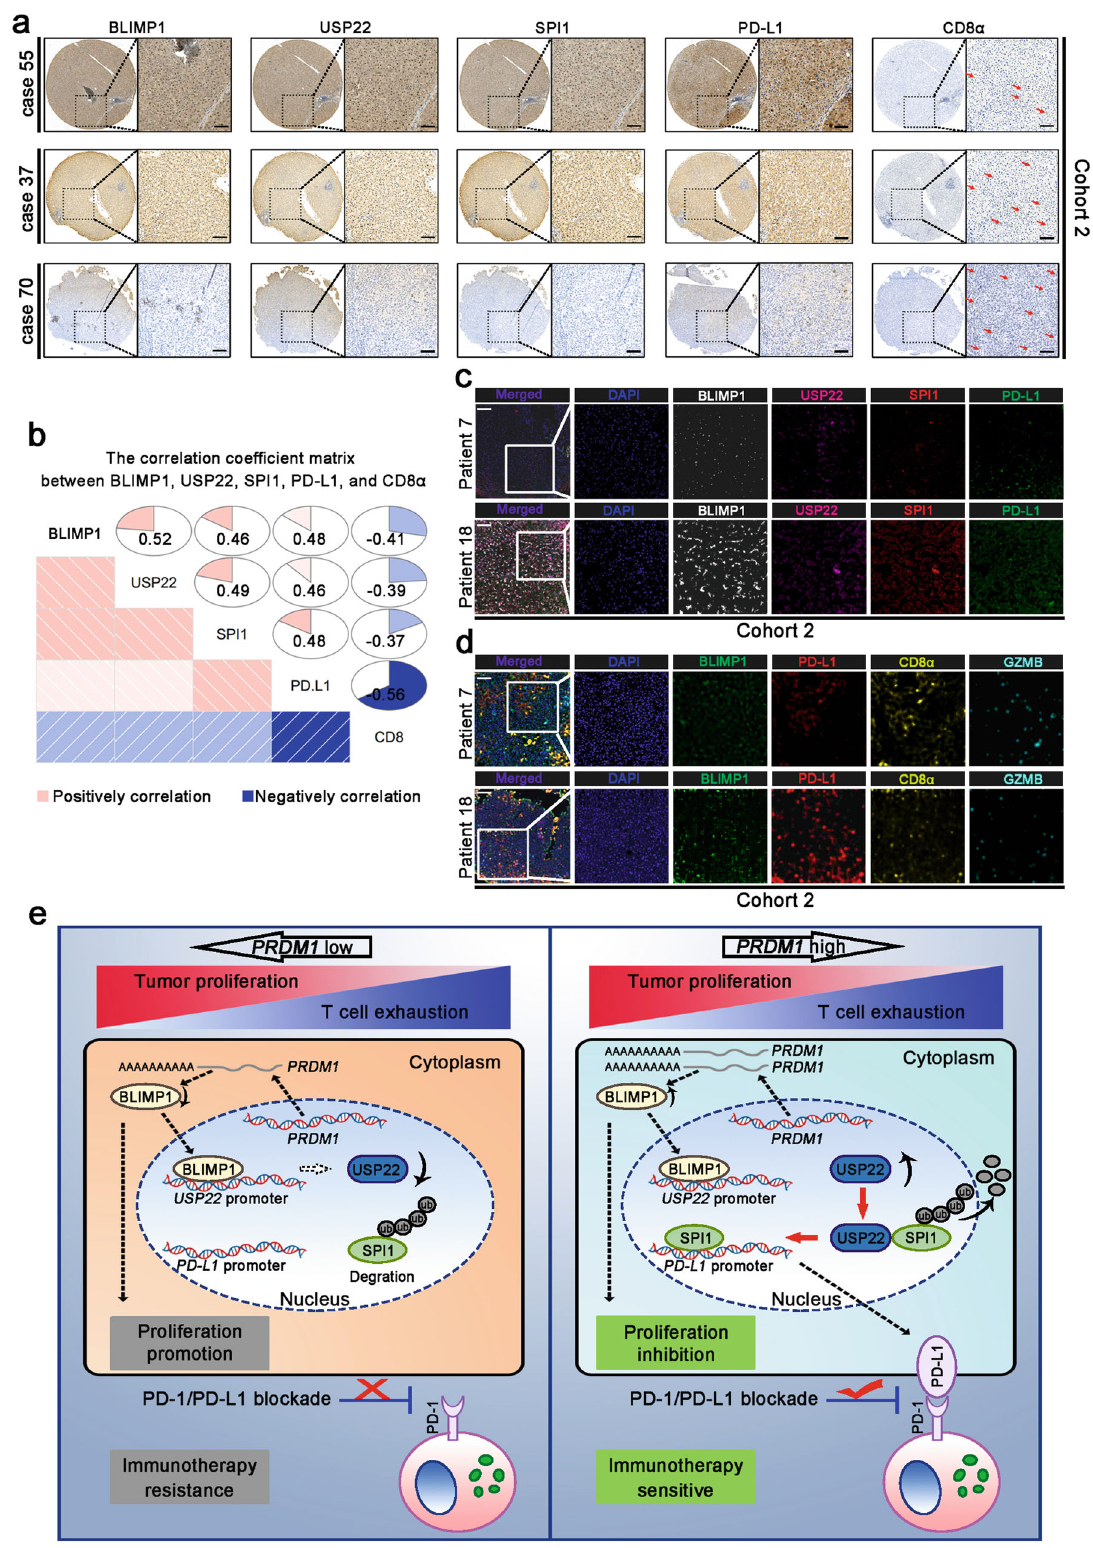
Fig.7|ThePRDM1-USP22-SPI1axisregulatesPD-L1levelsinpatientswithHCC. a , b Immunohistochemical staining of BLIMP1, USP22, SPI1, PD-L1, and CD8 α expression in patients with HCC. n =90 patients. Scale bars, 100mm. c , d Multi- color immunohistochemistry using BLIMP1, USP22, SPI1, and PD-L1 ( c ) or BLIMP1,